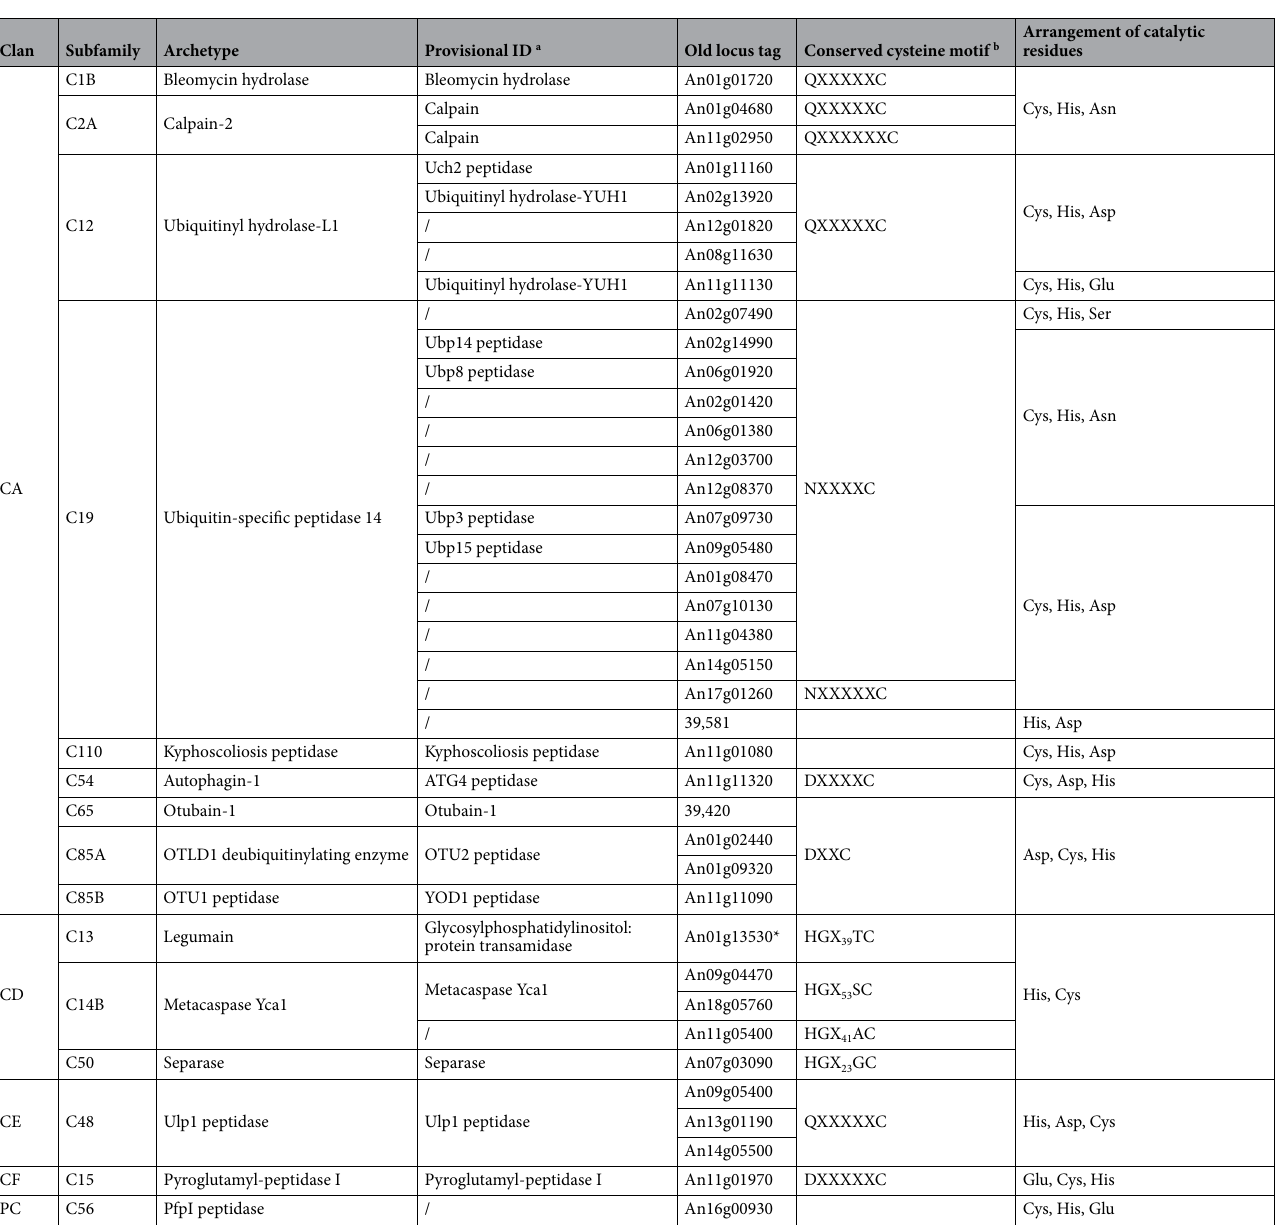
Table 5. Cysteine proteases encoded by A. niger strains CBS 513.88 and ATCC 1015. a /, not provisionally identified; b The putative catalytic residues are colored in pink. X represents any amino acid; * Secreted proteases that have been predicted by the six predictors, the unassigned extracellular cysteine protease An08g09840 is not presented in this